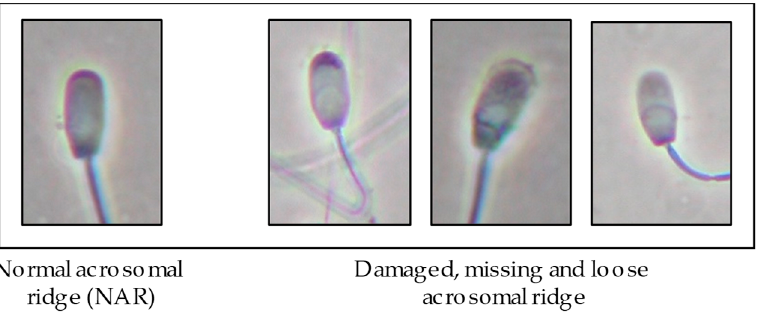
Figure 1. Scoring system to assess of acrosome status. Only the spermatozoa with normal acrosomal ridge (NAR) were considered in the results.